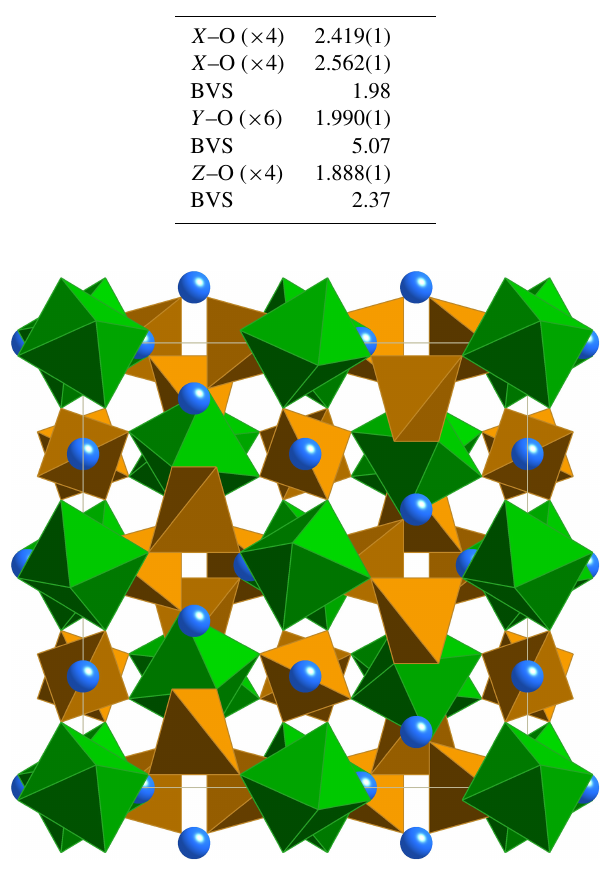
Figure 6. The monteneveite crystal structure seen along [100]. Blue spheres– X site (Ca); green octahedra– Y site (Sb); brown tetrahedra– Z site